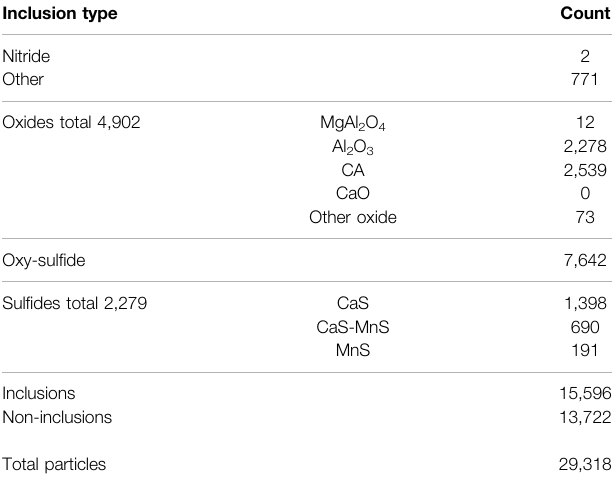
TABLE 1 | Breakdown of inclusion types in available dataset.